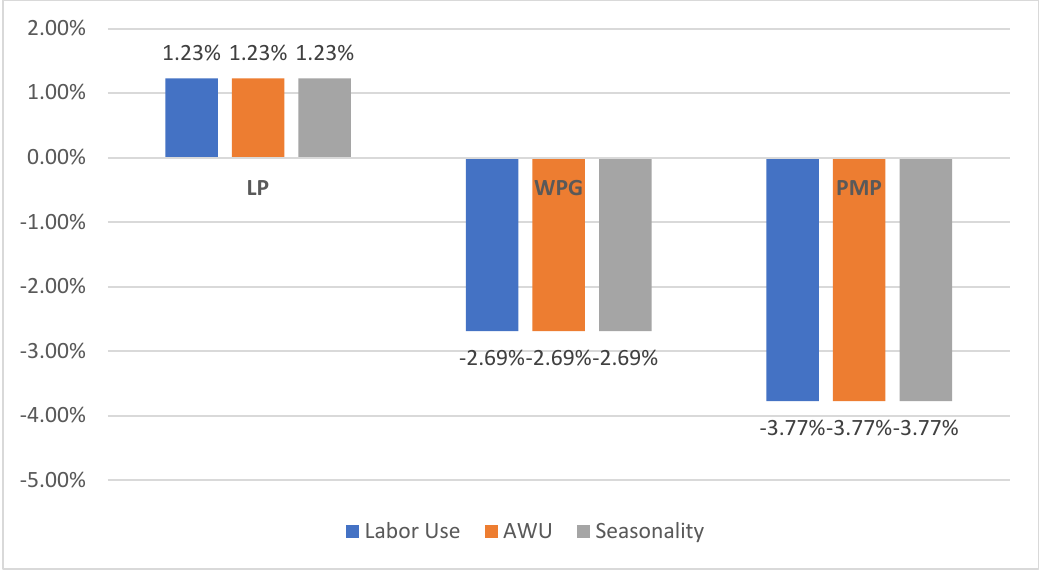
Figure 4. Changes in Social Indicators. Source: Our elaboration.